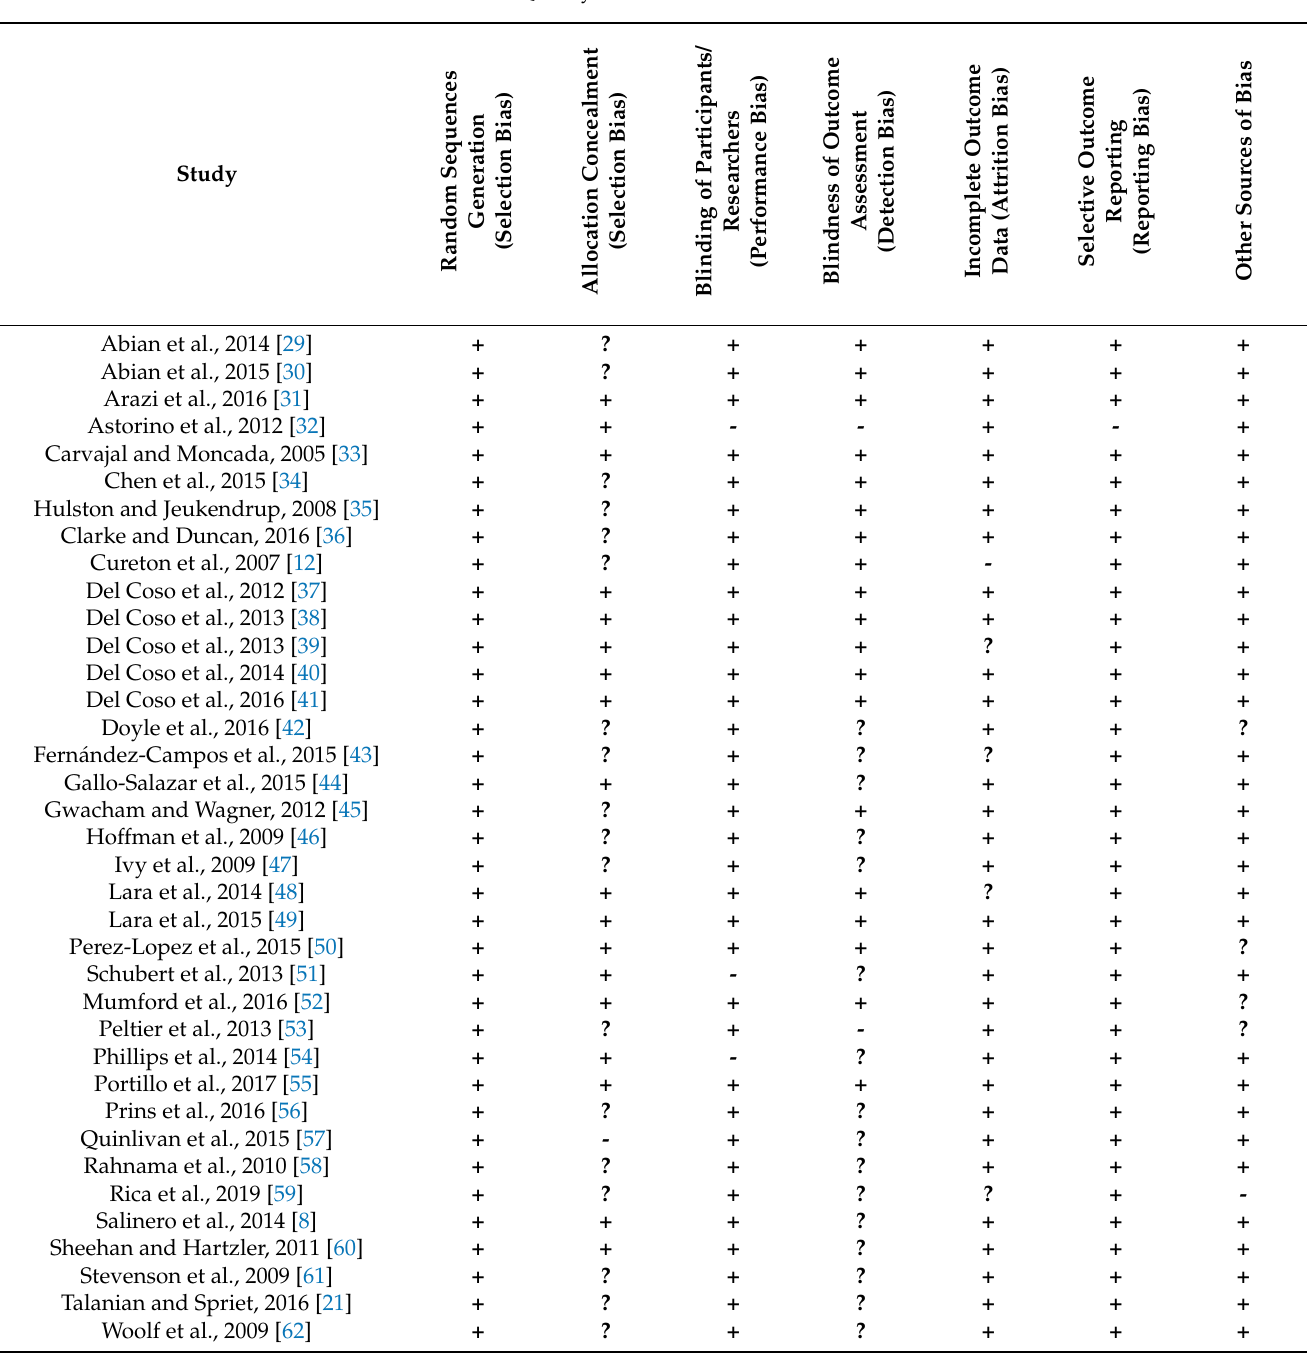
Table 1. Quality assessment and risk of